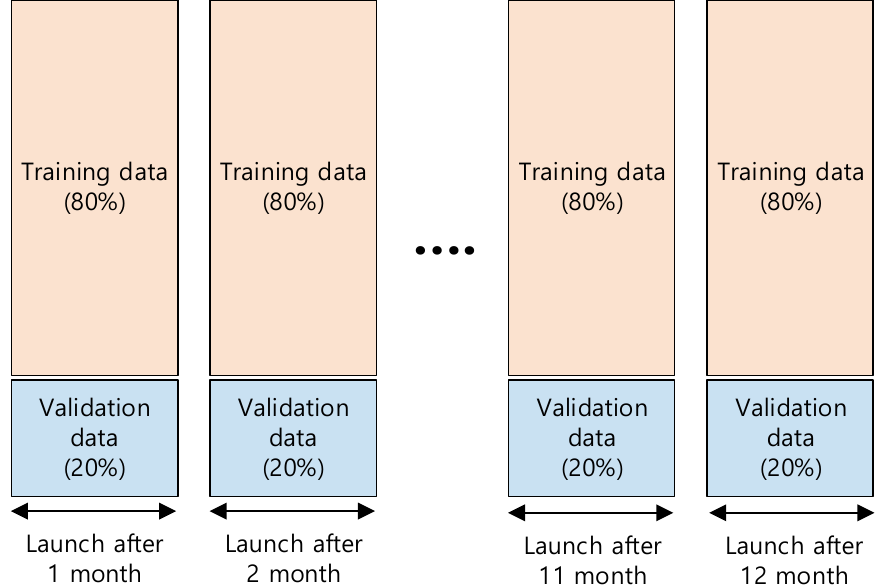
Figure 3. Dataset for SARIMA model training for battery current.